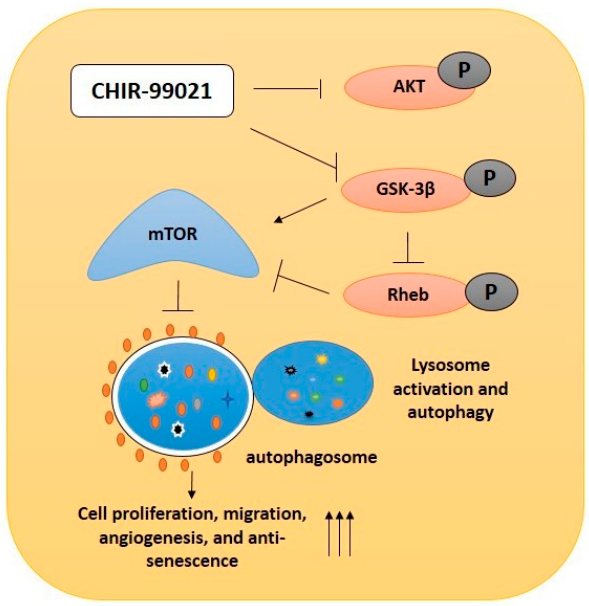
Figure 7. Graphical representation. Schematic representation of GSK-3 β inhibition in late EPCs using CHIR99021. The CHIR99021-induced GSK-3 β inactivation nonspecifically inhibited the phosphorylated form of AKT. Inhibition of GSK-3 β subsequently inhibited Rheb activity and suppressed mTOR activity. In addition, CHIR99021 treatment upregulated lysosome activation and autophagy, which further prevents cellular senescence and thereby increases bioactivity such as cell proliferation, migration and angiogenesis in late EPCs.